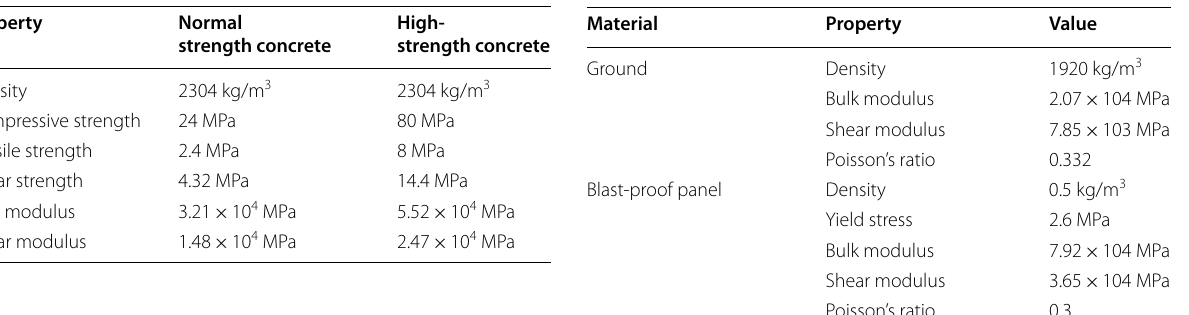
Table 3 Material properties of ground and blast‑proof